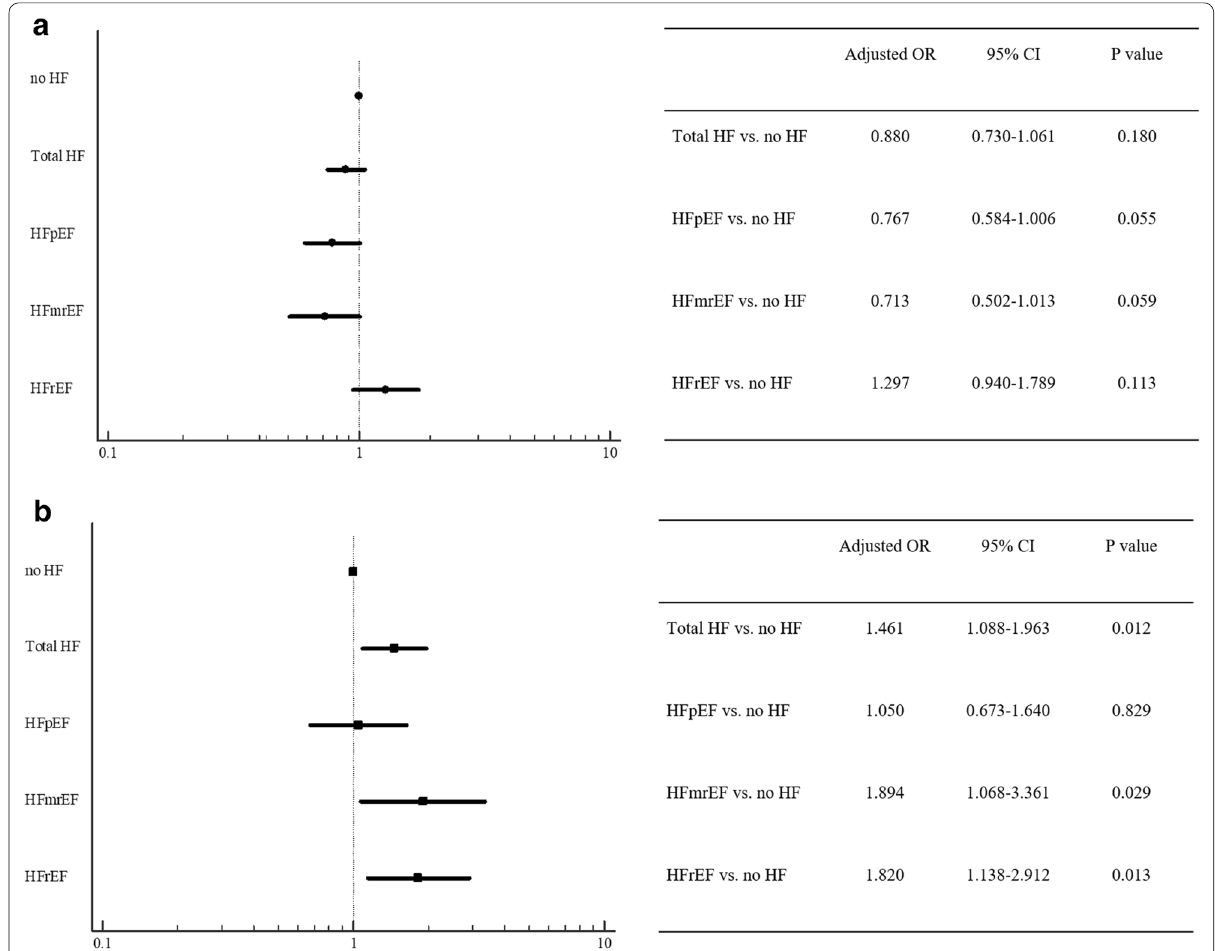
Fig. 1 Difference of symptom burden according to presence or type of heart failure in atrial fibrillation. a Presence of symptoms, b severity of symptoms (EHRA class 3), c multiple symptom (number of symptoms ≥ function, AF pattern, smoking status, alcohol consumption, blood pressure, and heart